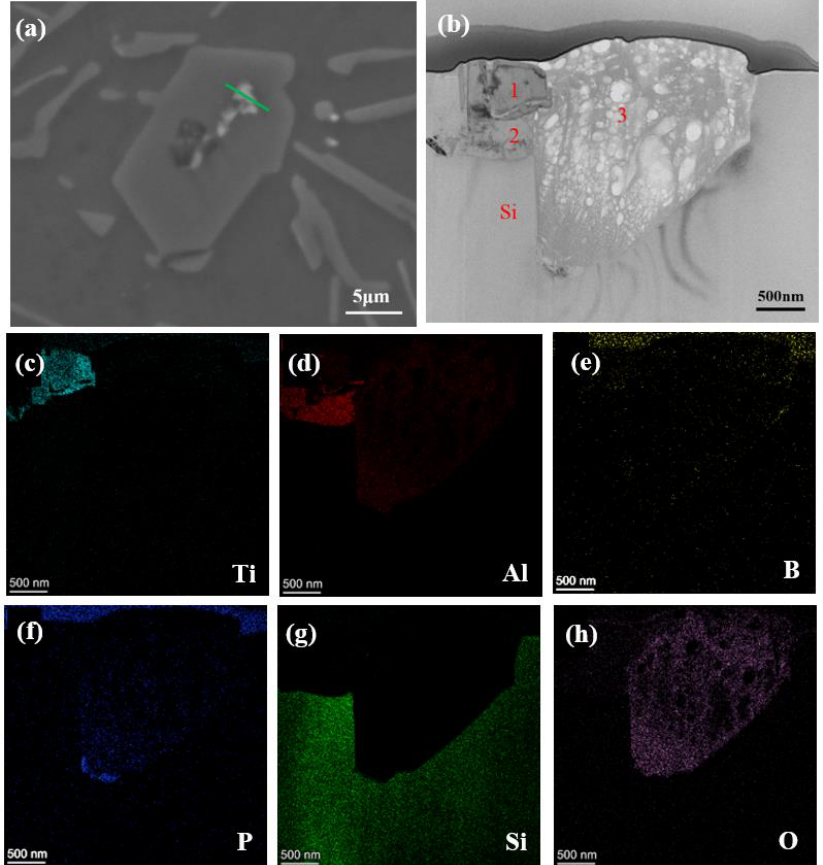
Figure 6. FIB analysis of the nucleation site of primary Si ( a ) cutting position, ( b ) section morphology, ( c – h ) HADDF diagram of the section.